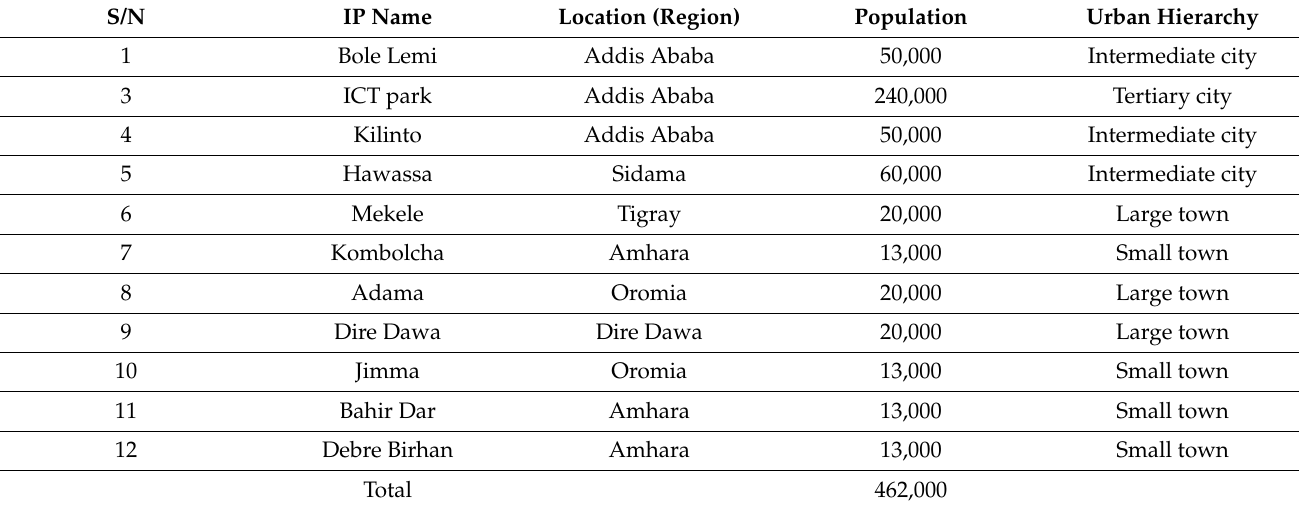
Table 4. Potential IPs-based cluster cities with urban hierarchy.